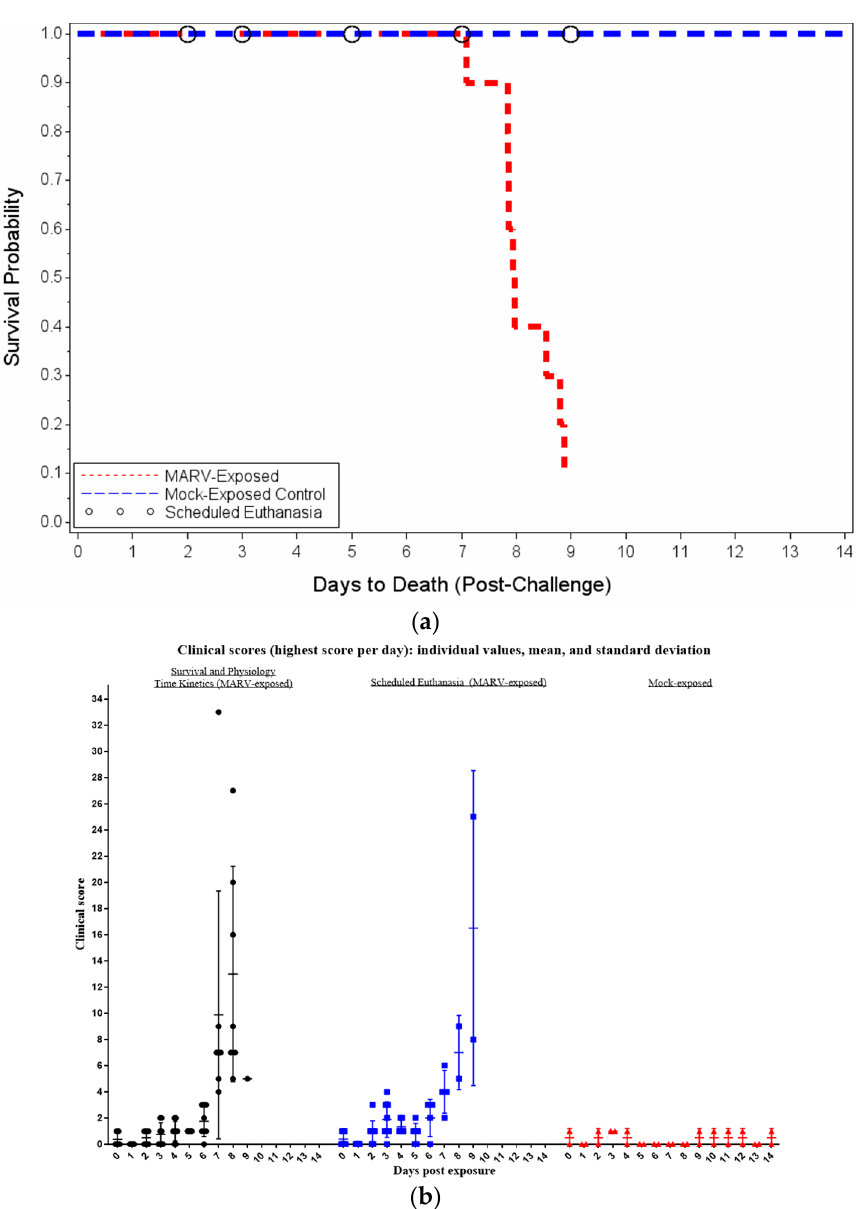
Figure 1. Survival and Clinical Scores. ( a ) Kaplan–Meier Time to Death Plot. ( b ) Daily Clinical Scores (Highest Score Per Day) in Cynomolgus macaques exposed to MARV or mock exposed: Group comparison with individual values, mean, and standard deviation displayed. One animal in the scheduled euthanasia group was found dead on the day of the scheduled euthanasia; this animal is included in the scheduled euthanasia group in the